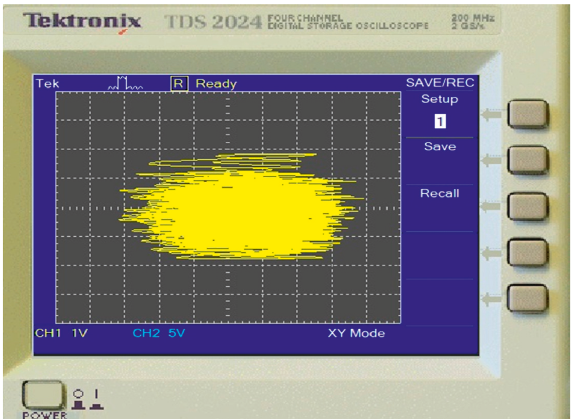
Figure 32: Electronic circuit simulation using MultiSim 14.0 for the new hyperchaotic two-scroll circuit (42) in the ( Z ordinate plane.